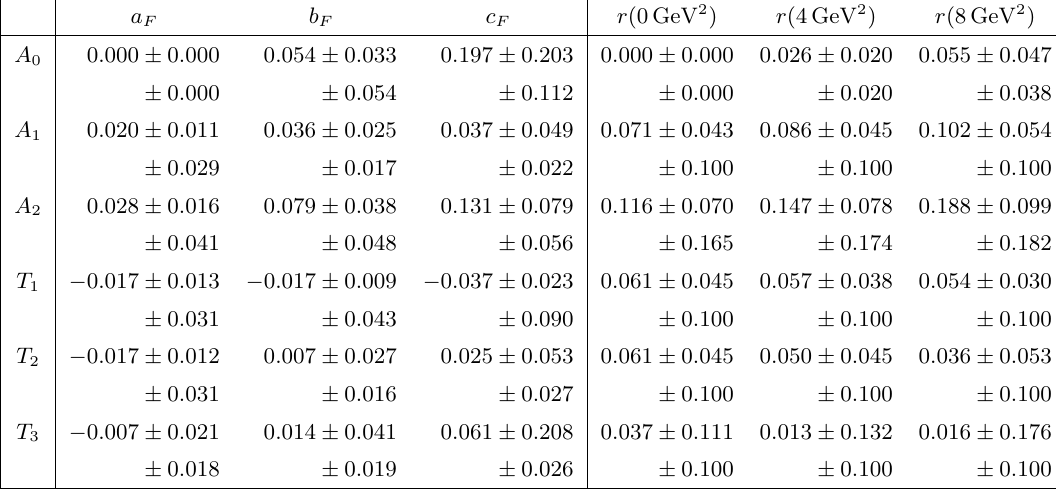
Table 1 . Results for the (cid:12)t of the power-correction parameters a F ; b F ; c F to the B ! K (cid:3) form factors from ref. [18], using the input scheme 1 in the transversity basis. Furthermore, the relative size r ( q 2 ) with which the power corrections contribute to the full form factors is shown for q 2 = 0 ; 4 ; 8 GeV 2 . In the (cid:12)rst line of each entry, the central value and the error obtained from the (cid:12)t are given. In the second line, the estimate (cid:1) F (cid:3) = 10% (cid:2) F LCSR is displayed for comparison. power corrections. Table 1 displays the results for the input scheme 1, de(cid:12)ned in eq. (3.5), and parametrising power corrections in the transversity basis f V; A (this corresponds to the default choice in ref.